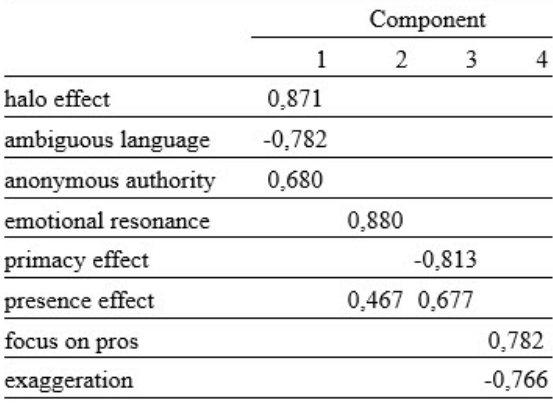
Table 3. Rotated Component Matrix “Selection of groups of components”